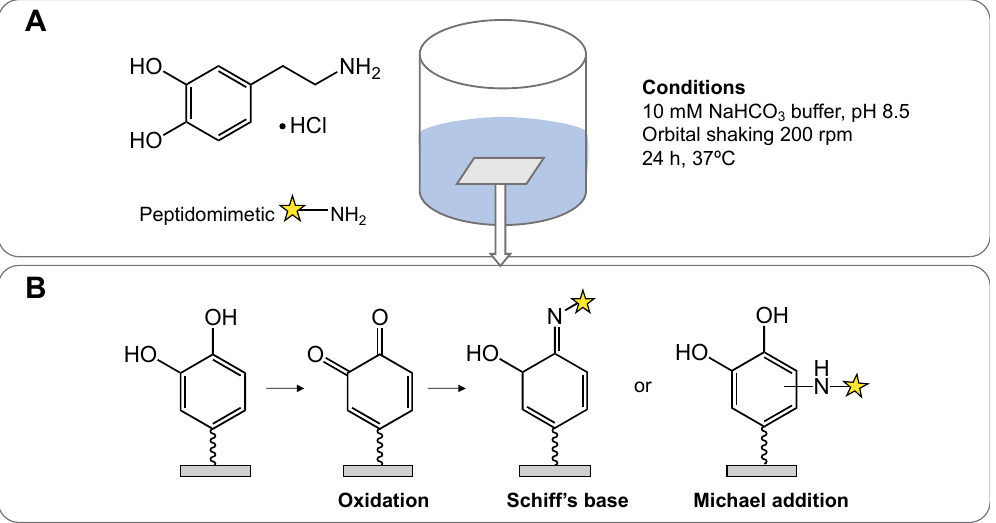
Figure 5. Polydopamine attachment of peptidomimetics to surfaces. ( A ) One-pot polydopamine– peptidomimetic surface coating. ( B ) Predicted reactions between surface-attached polydopamine functionalities and peptidomimetic amine moieties. Table 3. ‘One-pot’ polydopamine coating treatment groups and reagents. Treatment